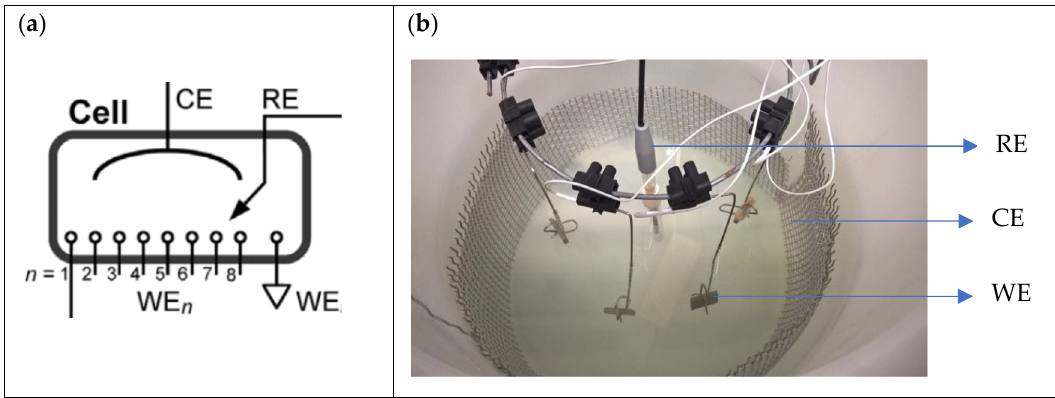
Figure 3. ( a ) Detail of Octopoti configuration [28] and ( b ) distribution of all electrodes in the container (RE: Reference Electrode; CE: Counter Electrode; WE: Working Electrode). 4 WEs are used in the tests.